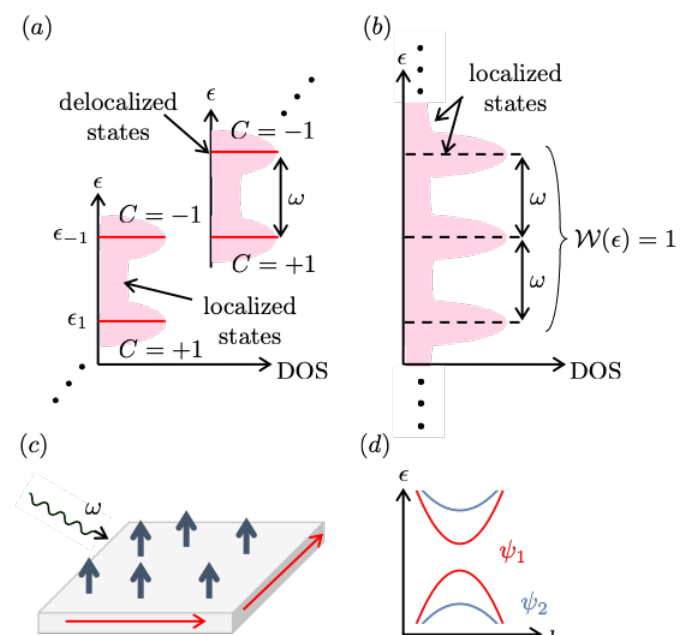
Figure 2: (a) Schematic density of states as a function of energy for a disordered QAH insulator. Anticipating a periodic driving with frequency ω , we show two consecutive Floquet zones. The spectrum consists mostly of localized states, but has delocalized states at energies ε ± within the Chern bands with C = ± 1. (b) Density of states of 1 the Floquet spectrum obtained when the system is driven at the resonant frequency ω = ε − ε − 1 + 1 . The driving couples the delocalized states from the two Chern bands and causes them to localize, so that all bulk states become localized. The winding number W ( ε ) at every quasi-energy ε is equal to 1. (c) Schematic of the thin film ferromagnetic TI, forming a QAH state (Section 3). The blue arrows represent the spin polarization and the red arrow around the edge of the film represents the chiral edge state. To this stationary system we add a driving field at frequency ω . (d) The spectrum of surface states is hybridized between the top and bottom of the film. In the absence of disorder, the surface states are described by two massive Dirac fields ψ and ψ 1 2